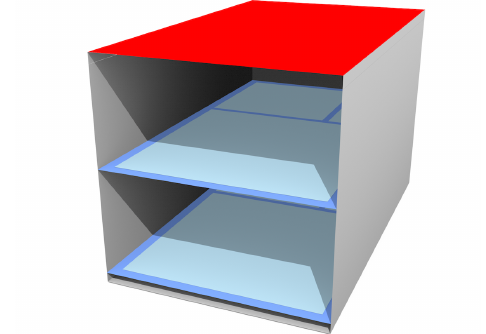
Figure 14. Integration of one of our LoD0 variants (LoD0-B1; see (b) in Fig. 12) of the interior LoD0 with the exterior LoD2. Different combinations of non-equal LoDs have advantages, but entail caution, such as terminological confusion and incompatibility (e.g. protrusions of